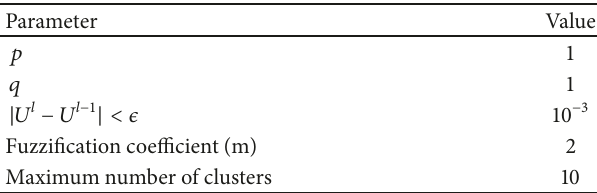
Table 1: FCM, GK, FPSO, and FCRM algorithms with the same parameters and values.